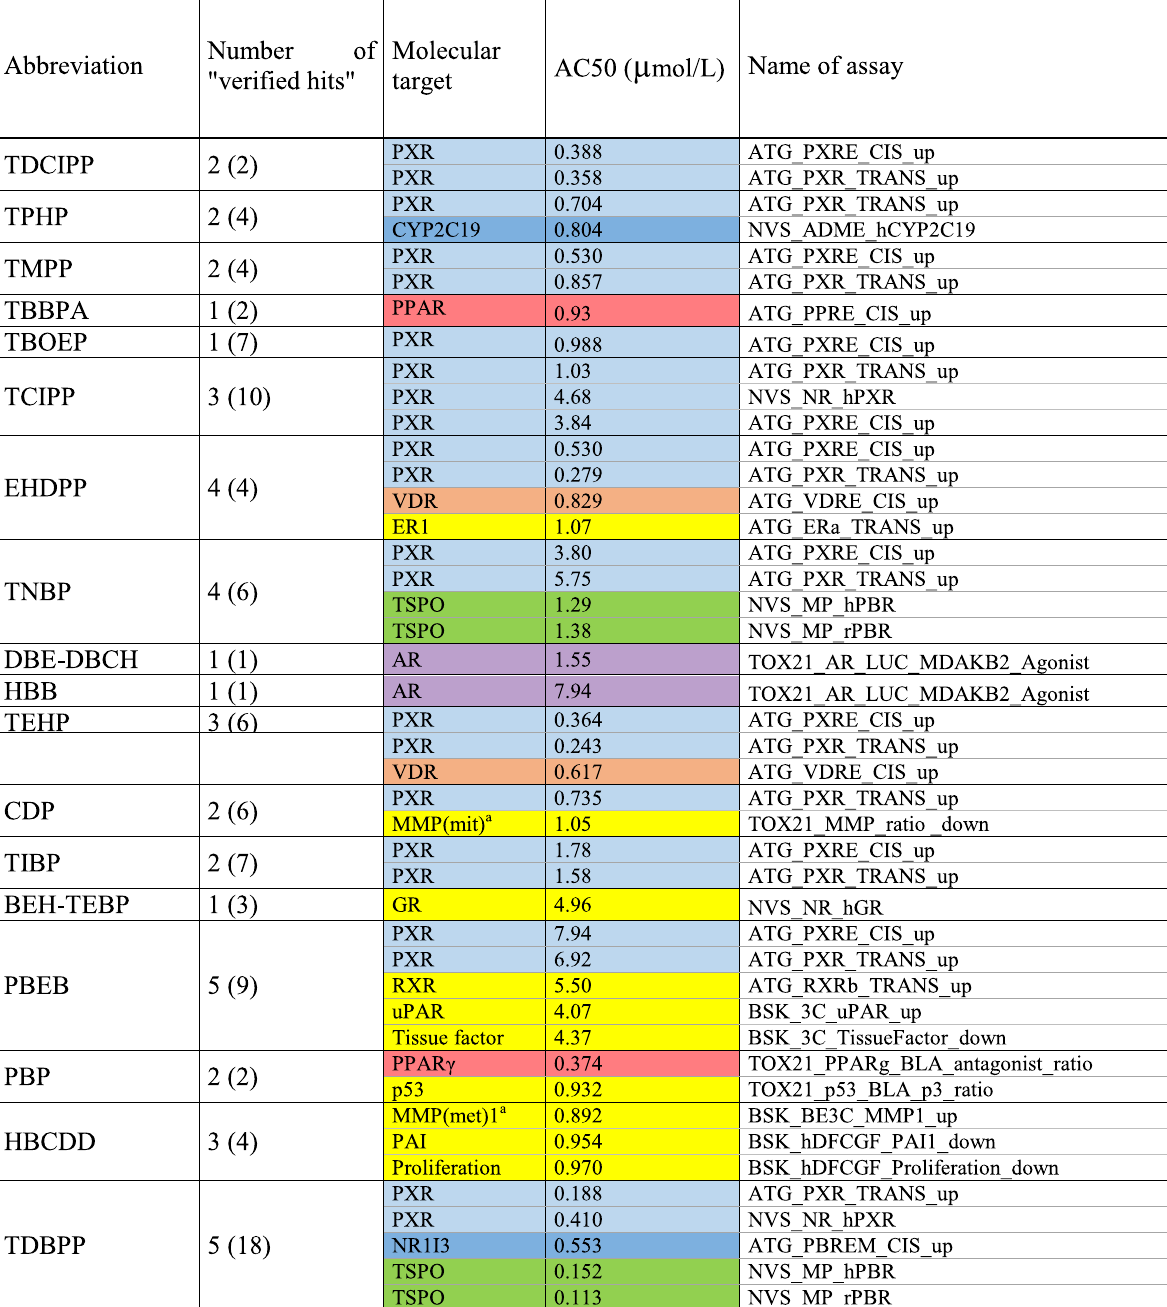
Table 3 Potential molecular targets (“verified hits”) identified in ToxCast